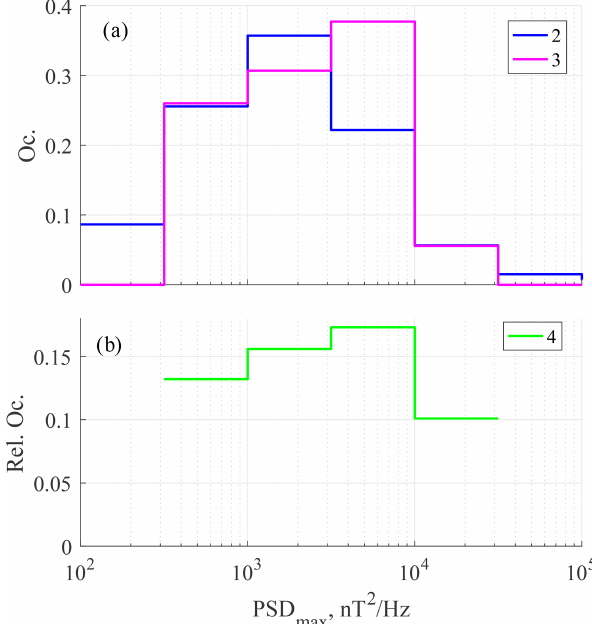
Figure 12. PSD distributions for groups 2 and 3 (a) and group 4 relative occurrence (b) .